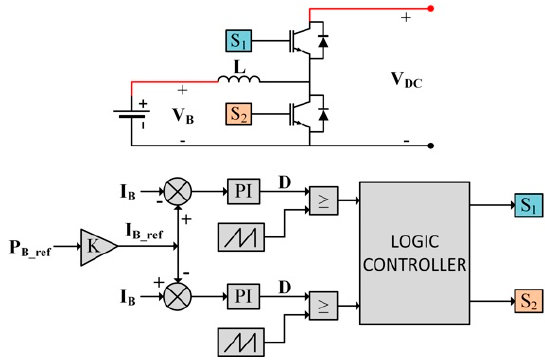
Figure 5. Overall structure of the battery energy storage (BES).